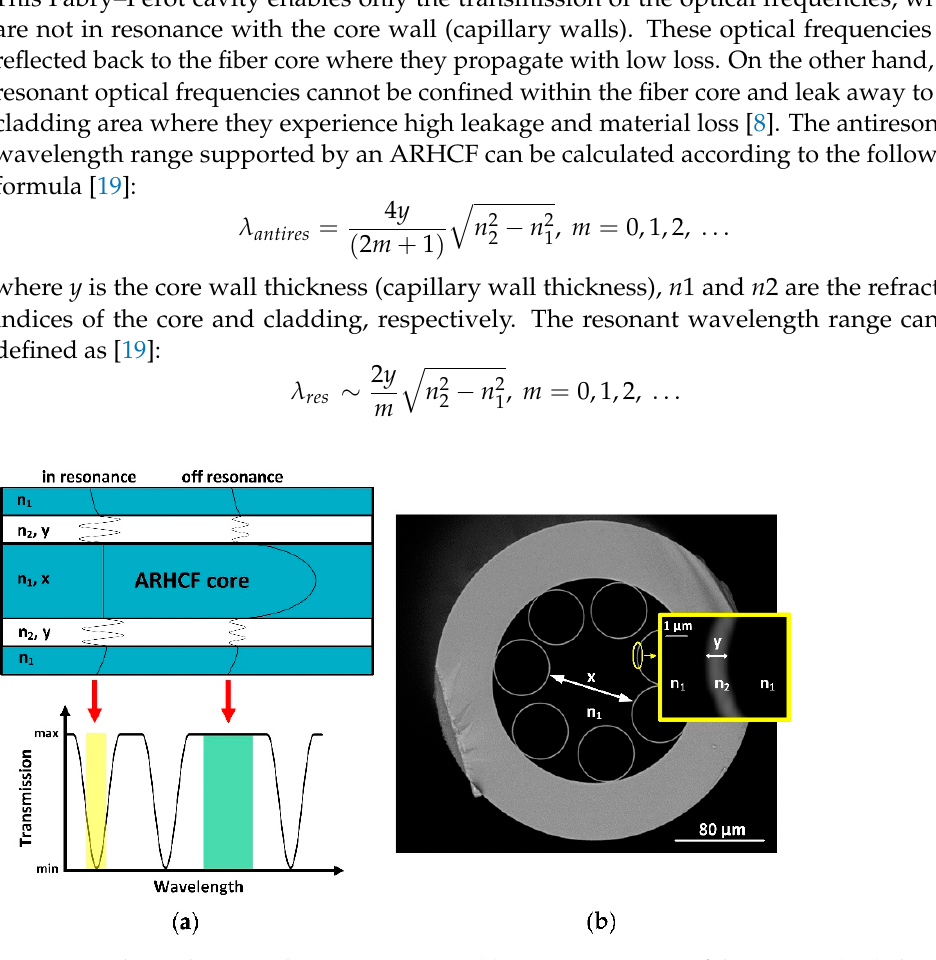
Figure 2. Light guidance mechanism in ARHCF. ( a ) 2D representation of the ARHCF (top) showing light transmission (bottom) in the core while the coupled light wavelength is in resonance and off resonance with the core wall. When the optical frequency (wavelength) does not match the resonant frequency of the Fabry–Perot cavity, the transmission of light in the core reaches its maximum. ( b ) SEM image of the ARHCF designed to operate at ~3.4 µm wavelength with a core wall thickness of ~1 µm. The inset shows the core boundary layer forming the resonant cavity. n 1 and n 2 —refractive indices of the air region (core, gaps between capillaries and inner parts of the capillaries) and capillary walls, respectively, x—core diameter, y—capillary wall thickness.